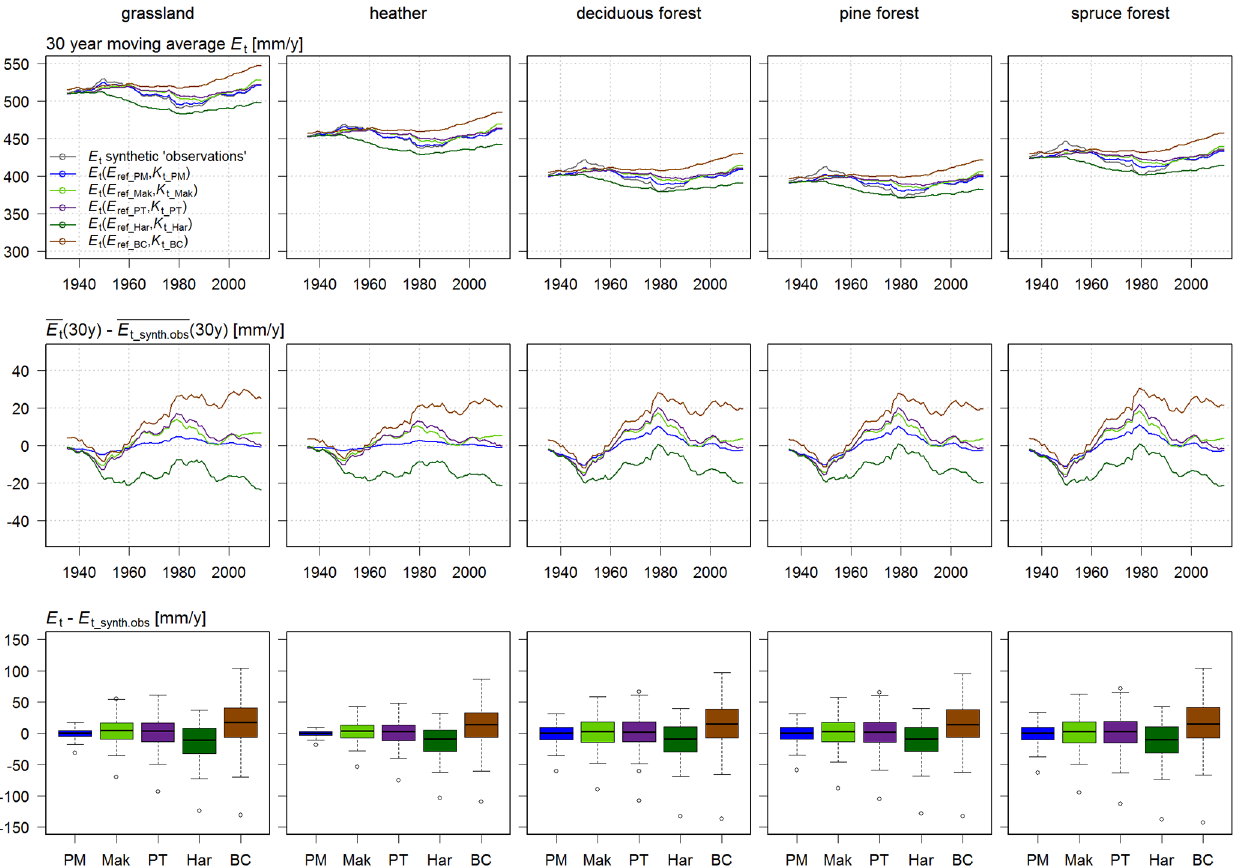
Figure 7. E t calculated for each vegetation class using each E ref method and matching K t calibrated on the 30-year period 1906–1935. Presented are 30-year moving averages in mm (top panels), and deviations with the synthetic E t for both the 30-year moving averages (center panels) and annual values (bottom